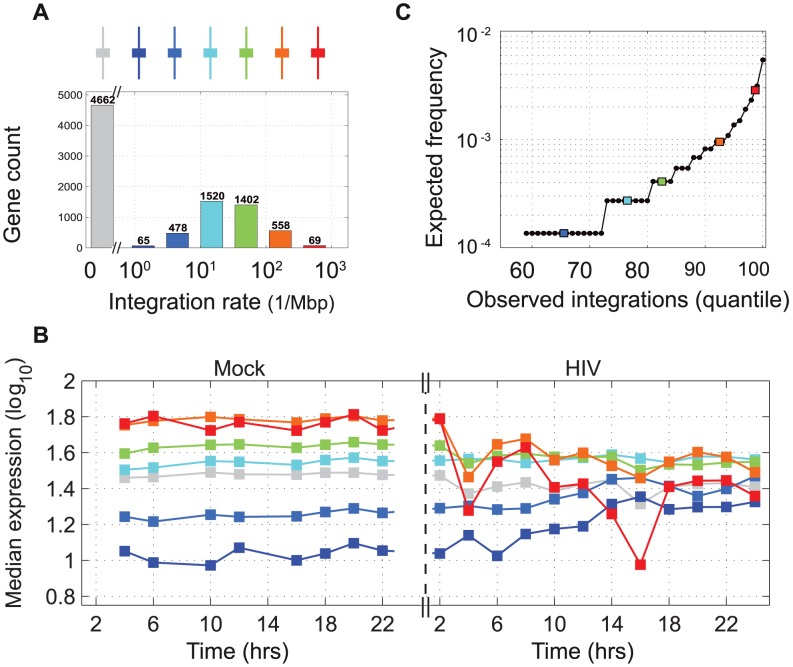
Host gene expression and viral integration.(A) Distribution of observed rates of integration: six gene groups (color coded) were defined based on the number of integrations per megabasepair (Mbp). Genes with no observed integration are depicted in grey. (B) Average level of expression of the six gene groups in Mock and HIV-infected cells during the 24-hour experiment. (C) Expected number of integration events in individual genes based on an empiric integration rate of 5.5 proviruses per haploid genome and on 40,430 observed unique integration sites (approx. 1% of all events).